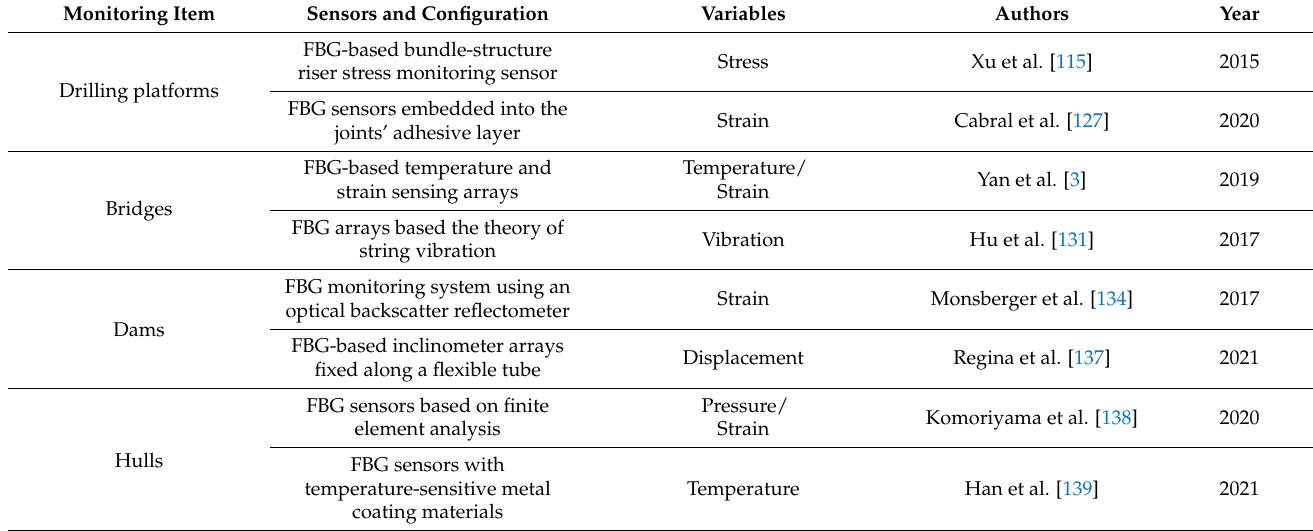
Table 2. WDM ‐ FBG ‐ based OFSs for SHM. Table 2. WDM-FBG-based OFSs for